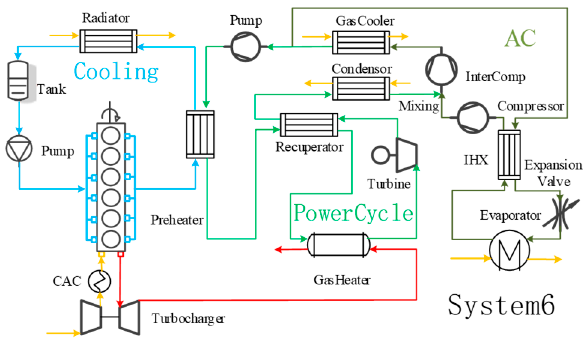
Figure 13. Co-compressing co-cooling secondary compression system.